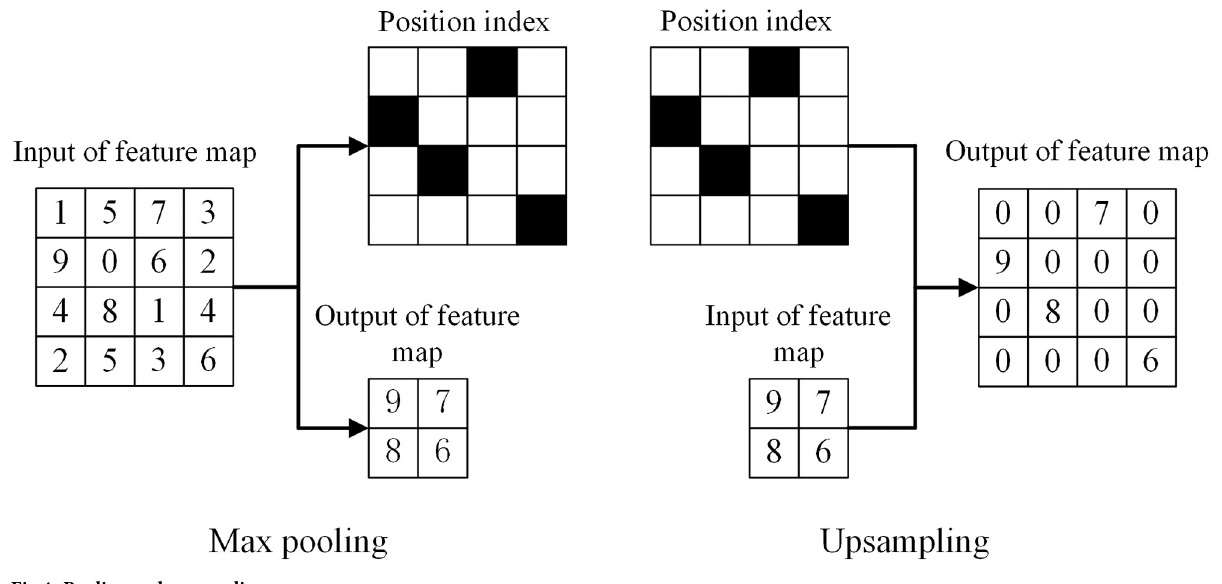
Fig 4. Pooling and